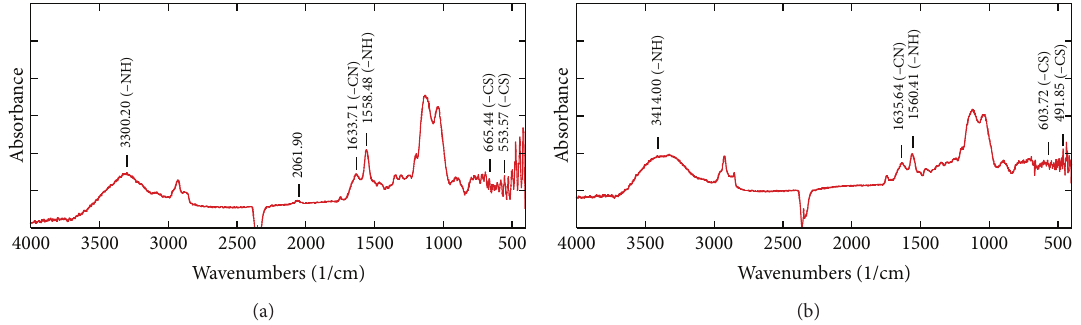
e n c b a o r s A b